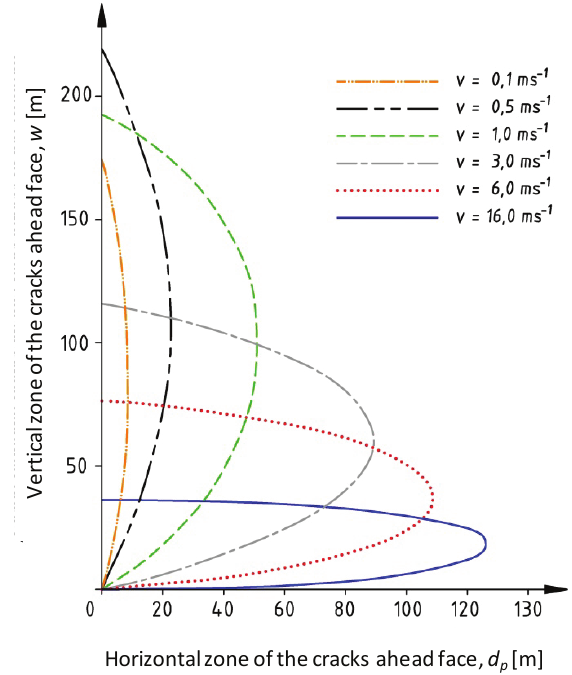
Figure 3: Function governing the formation of the first cracks ahead of an active